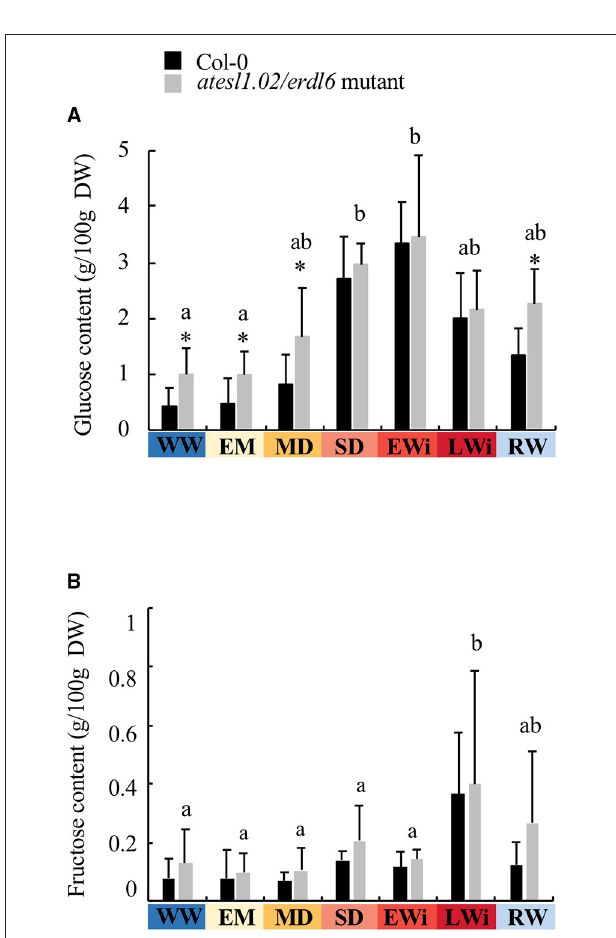
FIGURE 10 | (A) Glucose and (B) fructose contents in the leaves of A. thaliana Col-0 and atesl1.02/erdl6 mutant in WW, WD, and RW plants as a function of the four phases of water deficit: EM, early mild water deficit; MD, moderate water deficit; SD, severe water deficit; EWi, early wilting; LWi, late wilting. The values represent the mean of three biological replicates ( ± SD). Letters indicate statistically different values between the water-deficit phases determined by the Kruskal–Wallis test ( p < 0.05) followed by Dunn’s multiple comparisons test. Black asterisks correspond to significant differences between atesl1.02/erdl6 mutant and Col-0 plants, determined by the Mann–Whitney test ( p <